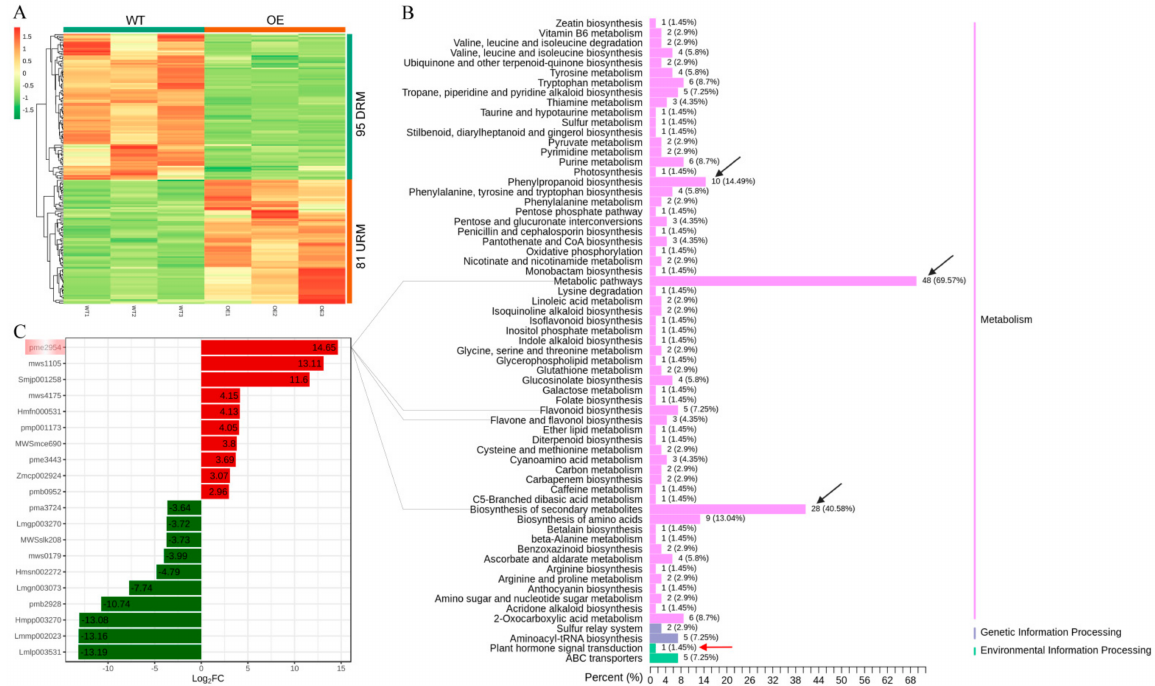
Figure 2. Multiple analysis of SDM (Significantly Different Metabolites). ( A ) Hierarchical clus- tering of SDMs. The x -axis and y -axis represent the specific sample name and SDM, respectively. Different colors in the heatmap represent the relative content of SDM. Red and green colors rep- resent high and low content, respectively. The WT and OE in the note bar above the heatmap represent wild type and overexpression, respectively. The URM and DRM in the note bar on the right side of the heatmap denote up-regulated metabolites and down-regulated metabolites, re- spectively. ( B ) KEGG (Kyoto Encyclopedia of Genes and Genomes) classification of SDM. x -axis represents the number and percentage of enriched metabolites in KEGG pathways, while the y -axis represents specific names of KEGG pathways. The black arrows indicate the top 3 KEGG path- ways with more number of SDMs. The red arrow indicates the plant hormone signal transduction pathway. ( C ) The top 10 SDM in WT vs. OE comparison group. The x -axis and y -axis represent Log 2 FoldChange and specific SDM index, respectively. Pme2954, quercetin; mws1105, gramine; Smjp001258, abrine; mws4175, D-glucurono-6,3-lactone; Hmfn000531, L-ascorbic acid (vitamin C); pmp001173, lyciumin A; MWSmce690, erythorbic acid, isoascorbic acid; pme3443, sinapinaldehyde; Zmcp002924, cyanidin-3-O-(2”-O-glucosyl)glucoside; pmb0952, thiamine (vitamin B1); pma3724, 1-O- feruloylquinic acid; Lmgp003270, scopoletin-7-O-glucuronide; MWSslk208, kaurenoic acid; mws0179, chlorognic acid methyl ester; Hmsn002272, demethyl coniferin; Lmgn003073, 5-O-feruloylquinic acid; pmb2928, gallic acid-4-O-glucoside; Hmpp003270, luteolin-4 (cid:48) -O-glucoside; Lmmp002023, caf- feoylspermine; Lmlp003531, luteolin-3 (cid:48) -O-glucoside; and Pme2954 with the largest difference was noted with pink gradient box. The grey lines indicate specific pathways for Pme2954